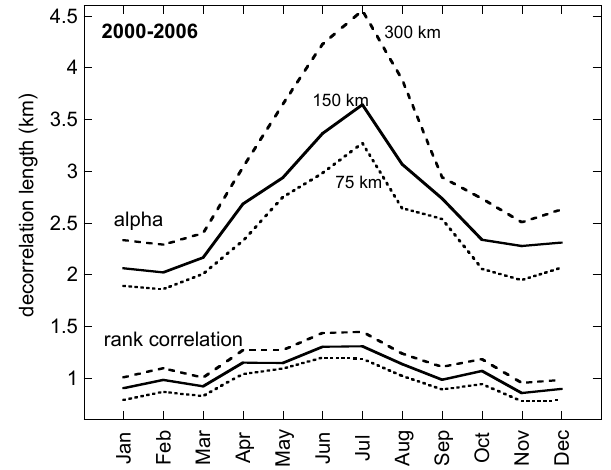
Fig. 3. The seasonal cycle of L α (top three curves) and L r (bottom three curves) decorrelation lengths from ensemble-averaged profiles of alpha and rank correlation like those shown in Figs. 1 and 2, but on a monthly instead of tri-monthly temporal scale. The L r curves are ordered with segment size in the same manner as the L α curves.